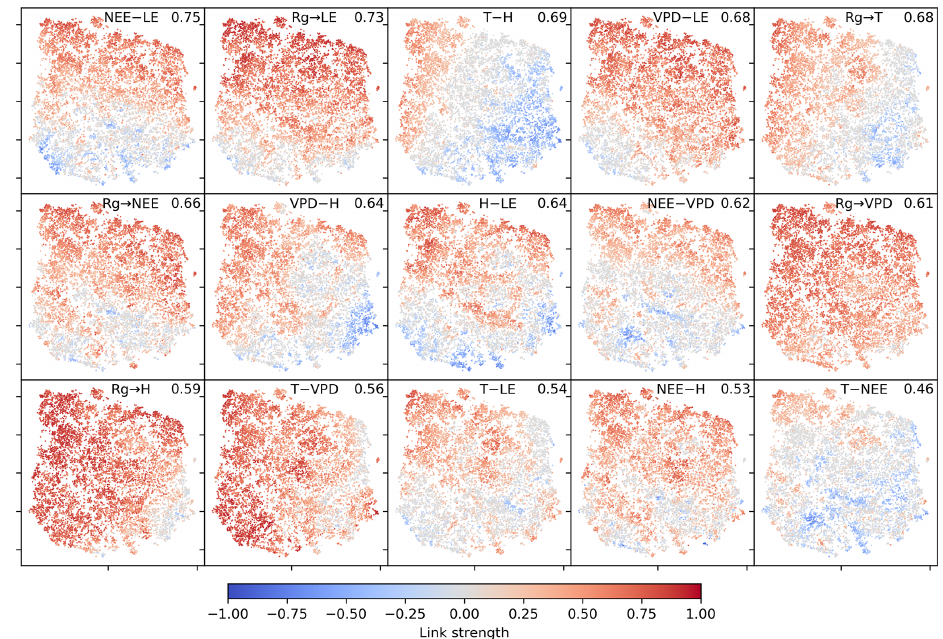
Figure 2. Two-dimensional embedding of 3-monthly biosphere–atmosphere networks realised via t -SNE. Shown is the distribution of link strengths among the networks. The strength is estimated via MCI partial-correlation values. Panels are sorted by the distance correlation of the link’s MCI value with the axes (value in the upper-right corner). As R g is set as a potential driver (PCMCI parameter selected_links; see Table A2), connections including R g are directed → . This setting does not affect the results (see Fig.